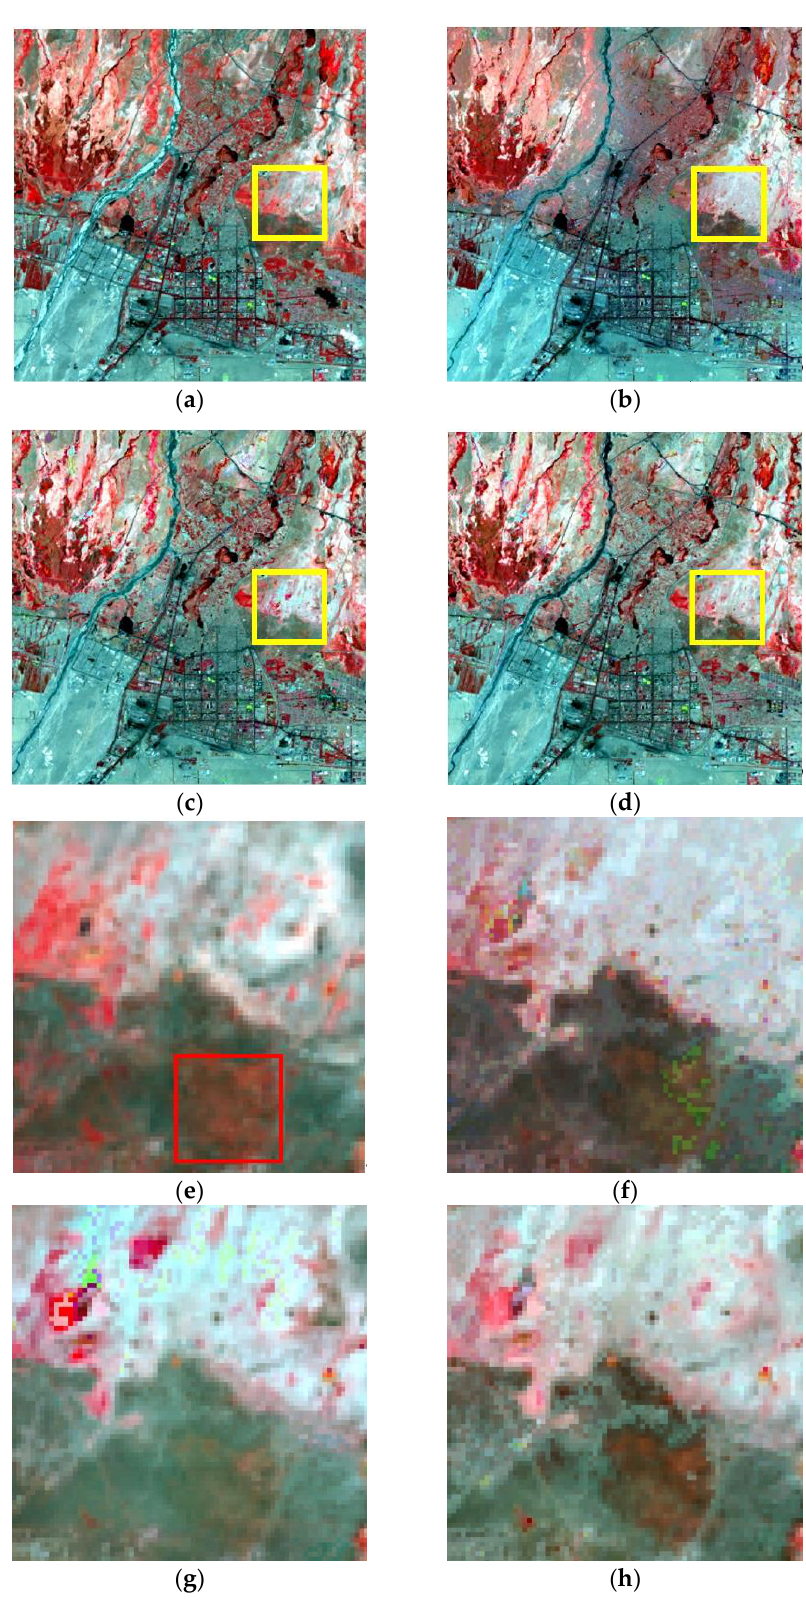
Figure 13. The fusion results of study area 2. ( a ) Actual Landsat image, ( b ) STARFM, ( c ) ESTARFM, ( d ) I-ESTARFM, ( e ) Actual Landsat image (highlight region), ( f ) STARFM (highlight region), ( g ) ESTARFM (highlight region), ( h ) I-ESTARFM (highlight region).